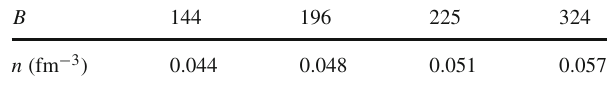
Table 3 Examples of configurations corresponding to a compression modulus K ∼